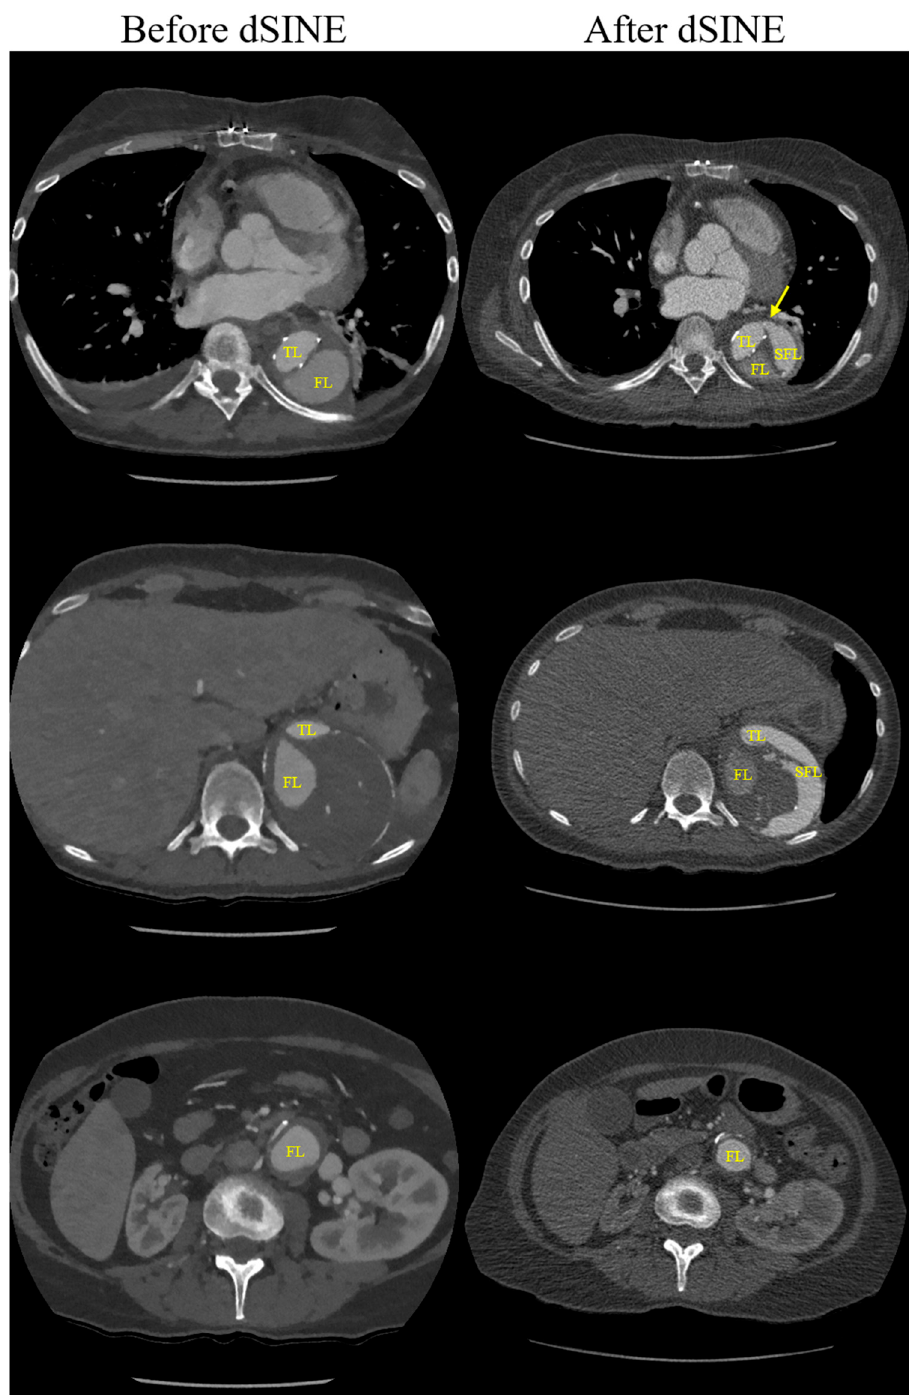
Figure 2. Postsurgical computed tomography angiography images comparing the conformation of the TBAD at different levels before and after the occurrence of the dSINE (marked with a yellow arrow), which determined the formation of a second false lumen (SFL). The true lumen (TL) is completely occluded distal to the emergence of the renal arteries. The initial false lumen (FL) exhibits partial